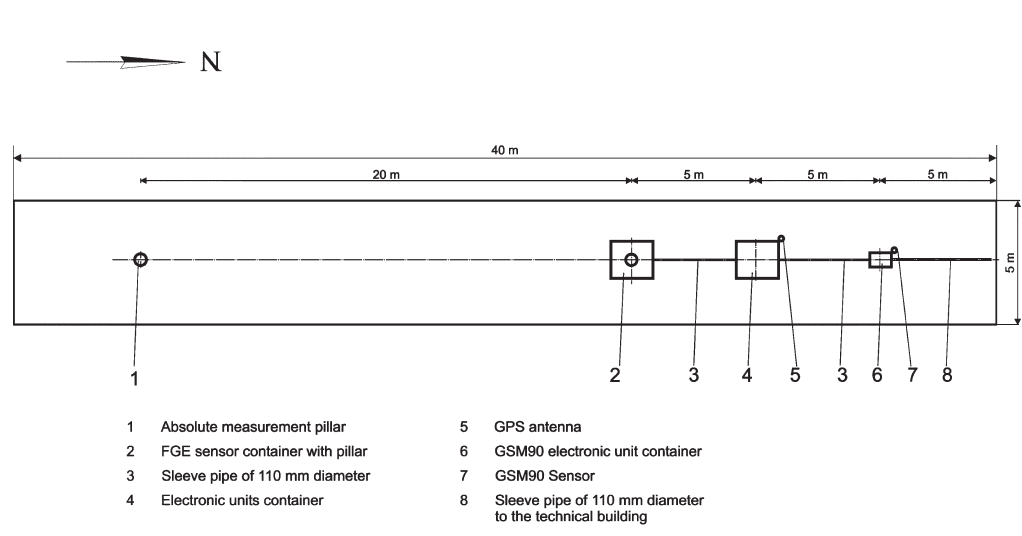
Fig. 9. Outline of the observatory